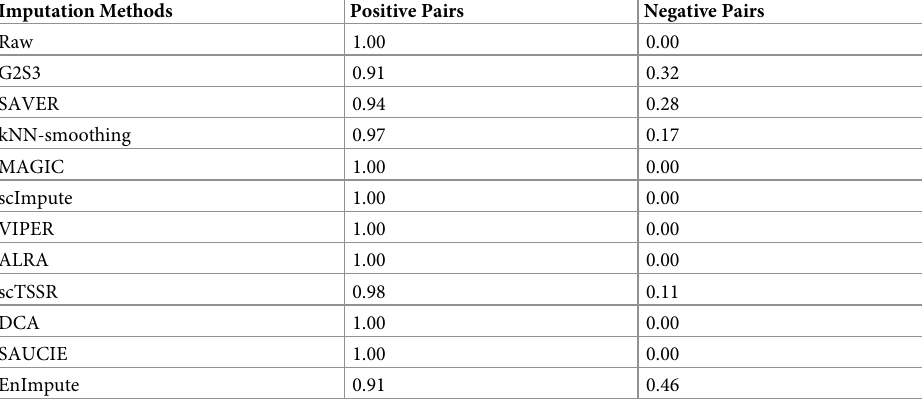
Table 2. Fraction of periodic gene pairs with correct direction of correlation in the raw and imputed data by each